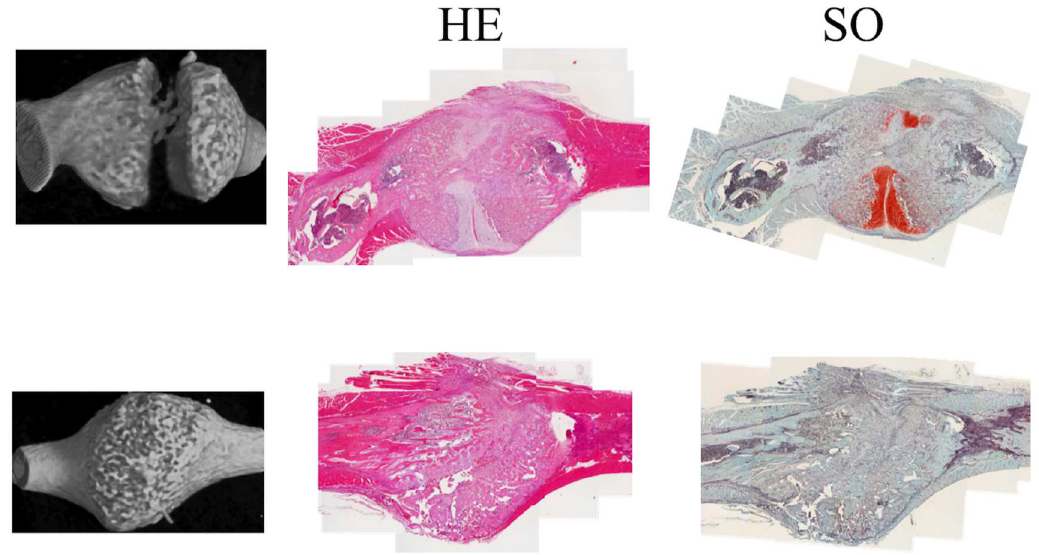
Fig 7. Microscopic images of fracture callus stained with hematoxylin and eosin (H&E) and safranin-O. Representative images of non-unionribs are in the upper row and those of union in the lower row: micro-CT images (left column), histological images stainedwith H&E (middle column)and histological images stainedwith safranin-O (right column). Magnification = 40X, scale bar = 1